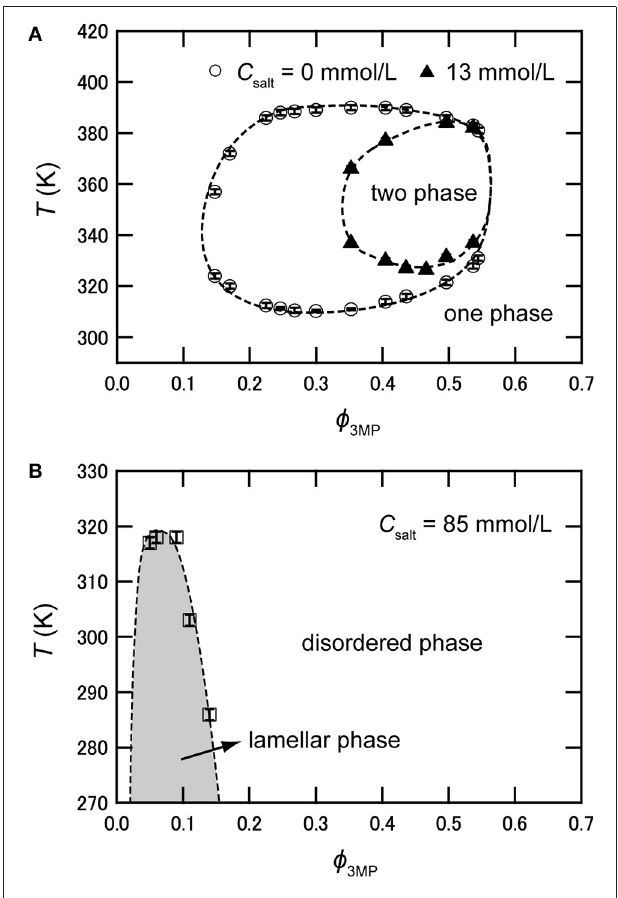
FIGURE 2 | (A) Phase diagram of D 2 O/3MP and D 2 O/3MP/NaBPh 4 (13 mmol/L). (B) Phase diagram of D 2 O/3MP/NaBPh 4 (85 mmol/L). It is noted that the two-phase region does not exist at this salt concentration. The data are taken from Sadakane et al. [24].